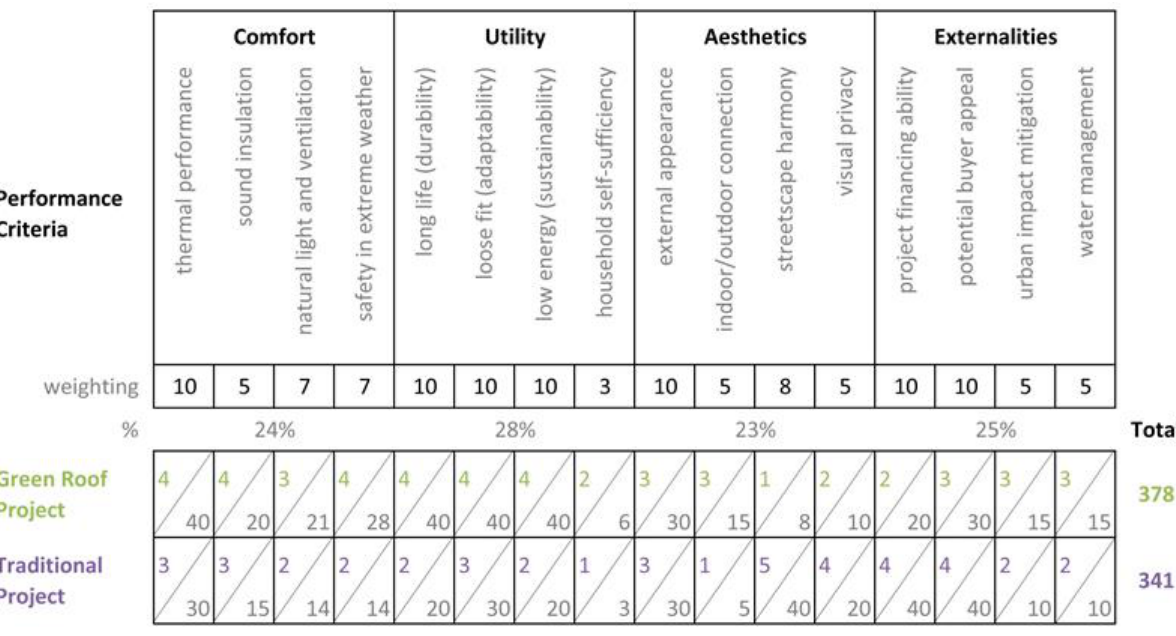
Figure 7: Social performance